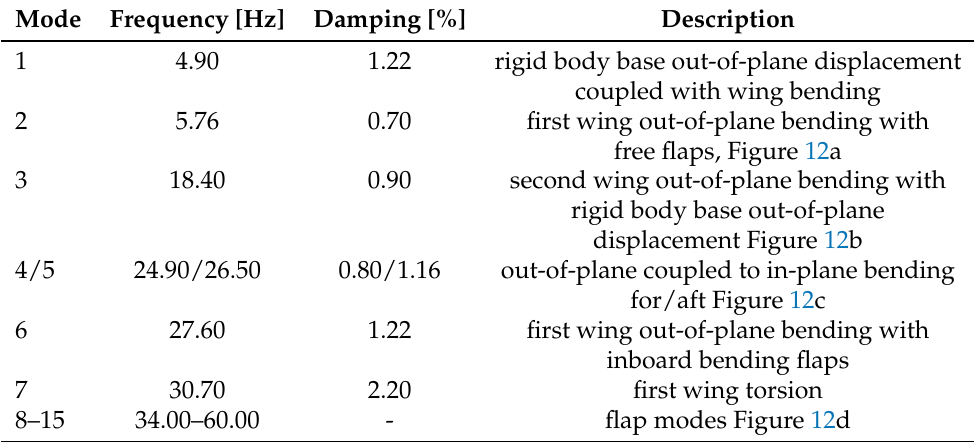
Table 2. SmartX-Alpha demonstrator measured modal properties.